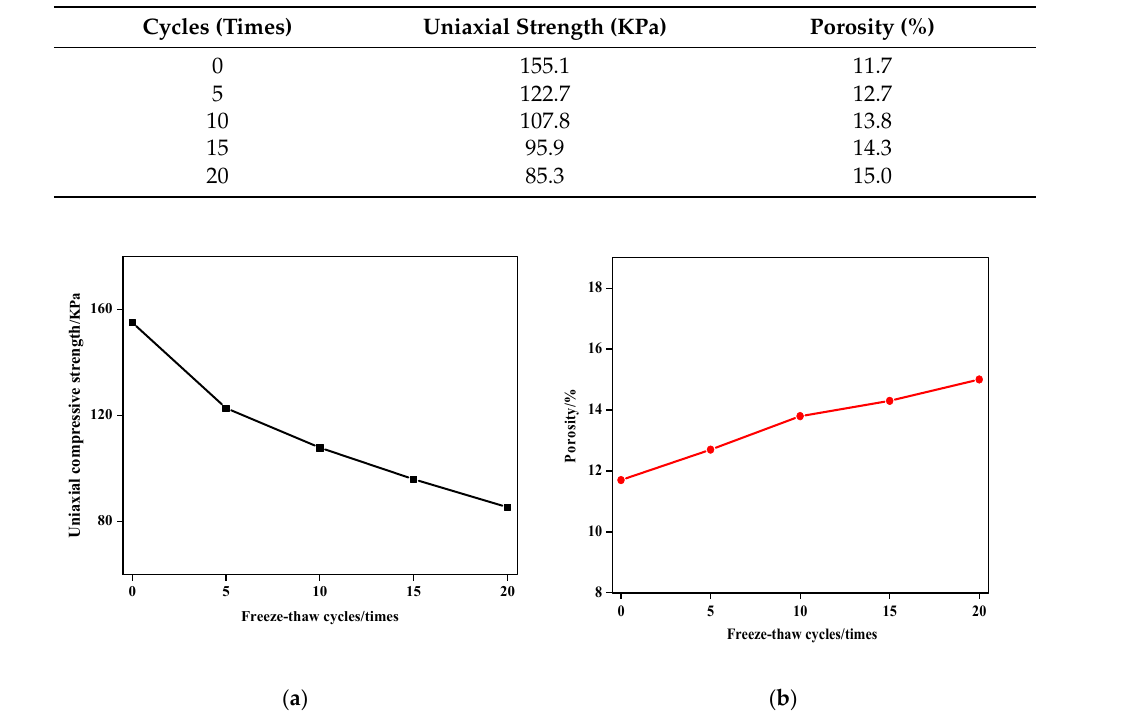
Figure 4. Variation pattern of strength and porosity of samples: ( a ) Strength; ( b ) Porosity.